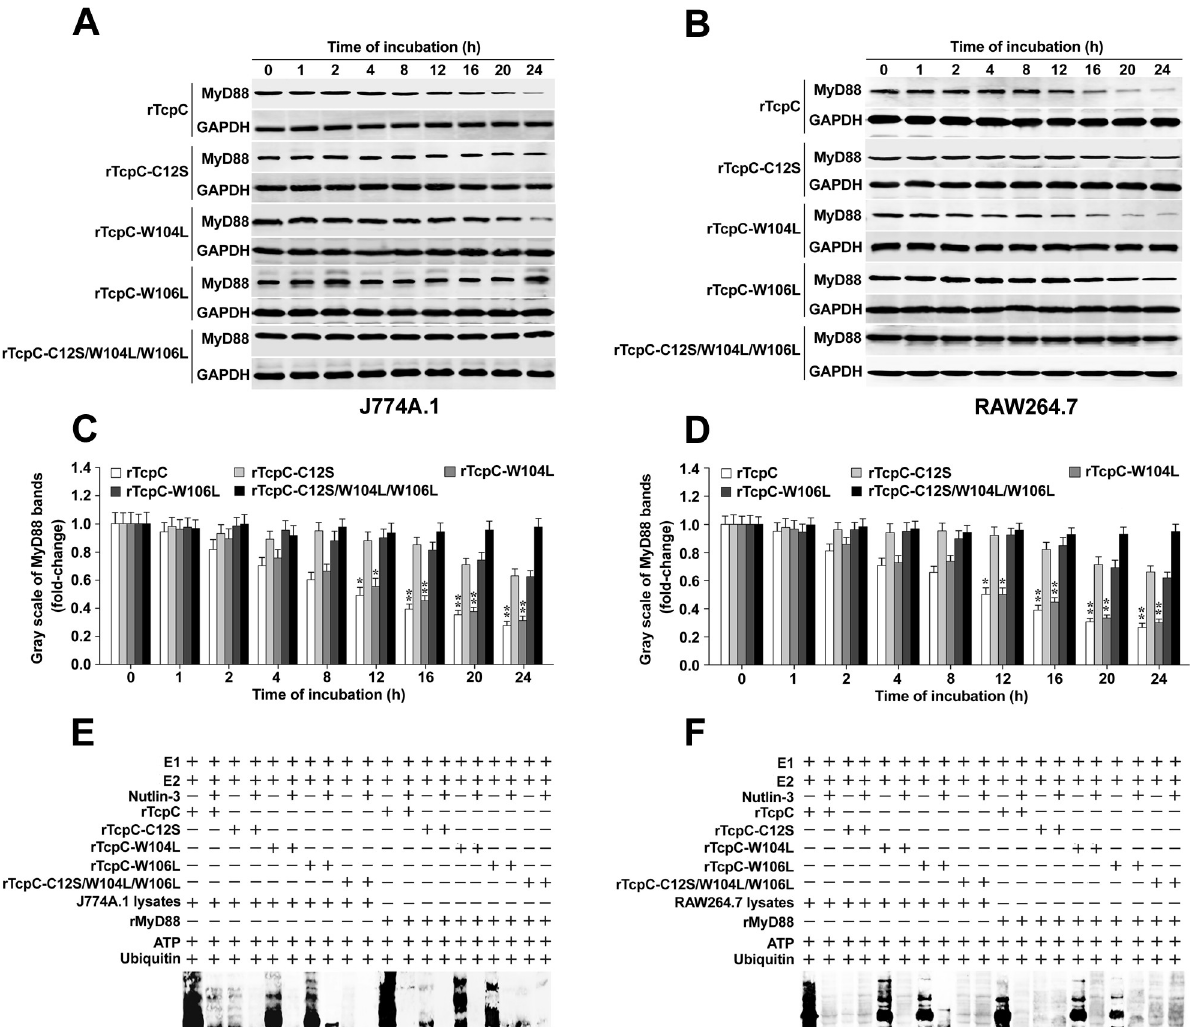
Fig 7. C12 and W106 point mutations abrogate E3 activity of rTcpC. (A-B) Western Blot analyses to examine the influence of rTcpC mutants on MyD88 degradation in J774A.1 and RAW264.7 respectively. (C-D) Gray scale analyses of MyD88 bands from three independent experiments as described in A-B. � : p < 0.05, �� : p < 0.01 vs the gray scale values reflecting the MyD88 level in cells treated by the prototype rTcpC at 0 h. (E-F) Ubiquitination kit analyses to examine the influence of rTcpC mutants on ubiquitination of both proteins in lysates from J774A.1 and RAW264.7 and